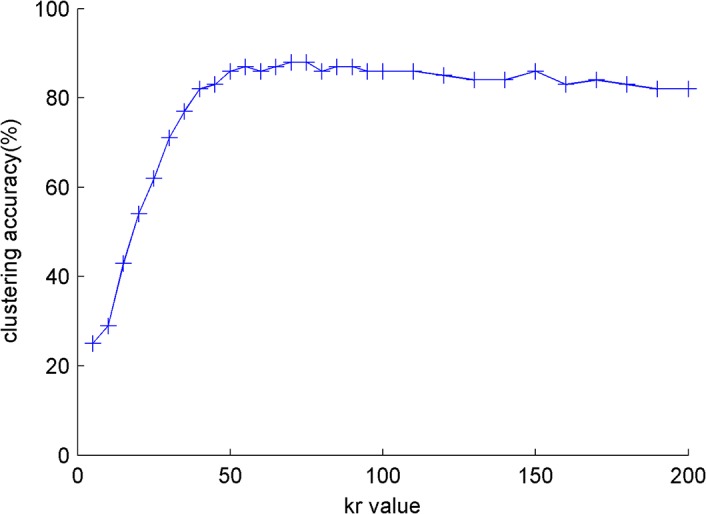
The influence of kr for clustering authors on s
small.